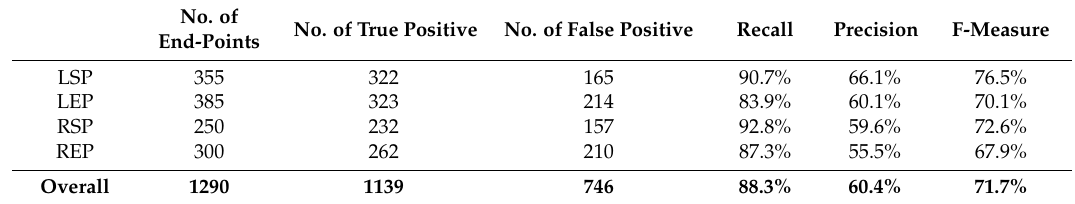
Table 8. Performance of the method [31] in